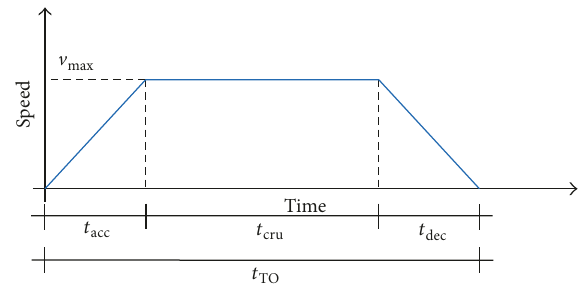
Figure 1: Speed profile in the case of a Time Optimal (TO)